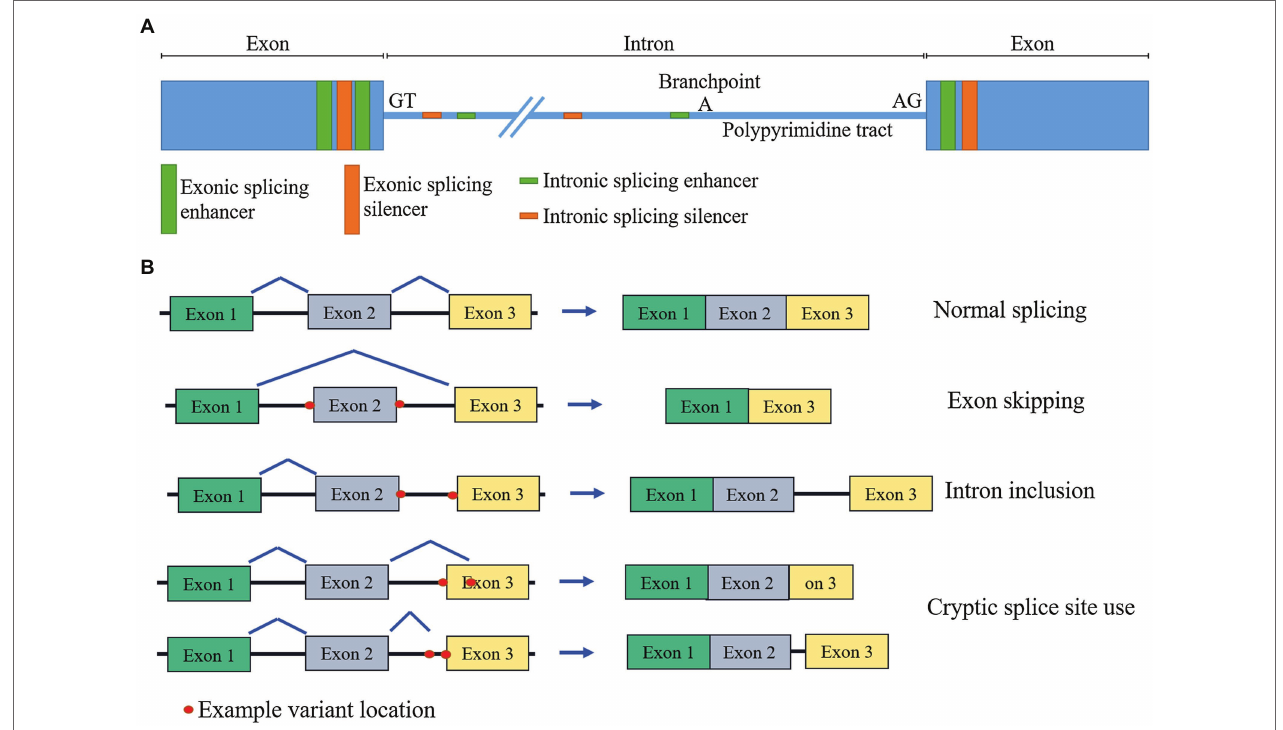
FIGURE 1 | Schematic diagram of (A) cis splicing regulatory elements and (B) effects of splicing disruption on